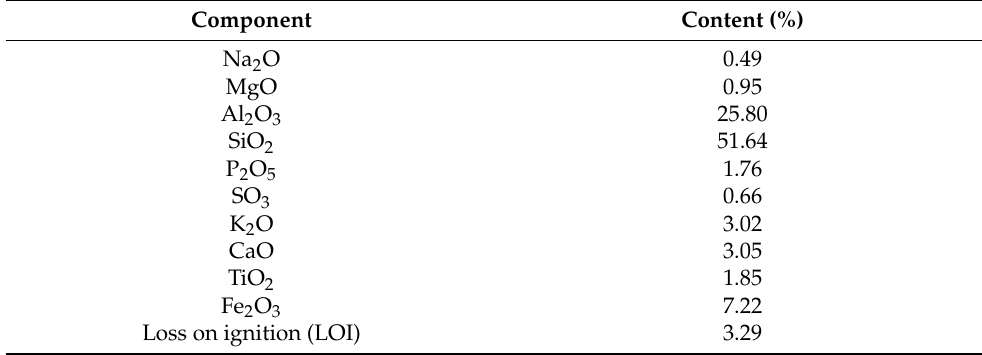
Table 1. Chemical composition of FA Jaworzno (%).